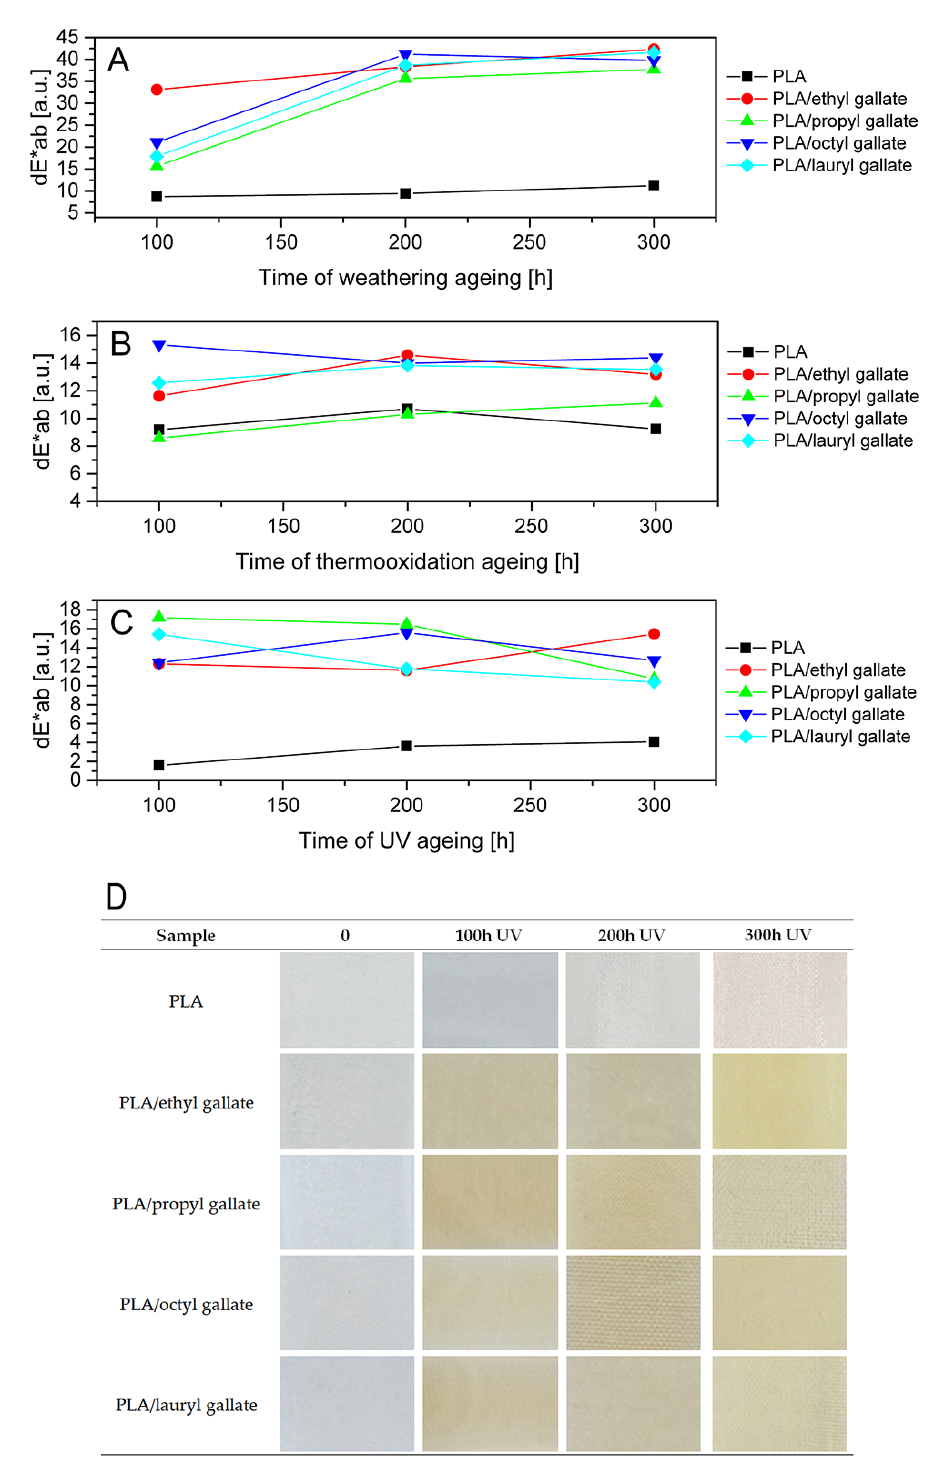
Figure 10. Changes in color of PLA after weathering ( A ), thermooxidation ( B ), and UV ( C ) aging. Visual change of color of PLA containing gallates before and after UV aging ( D ).